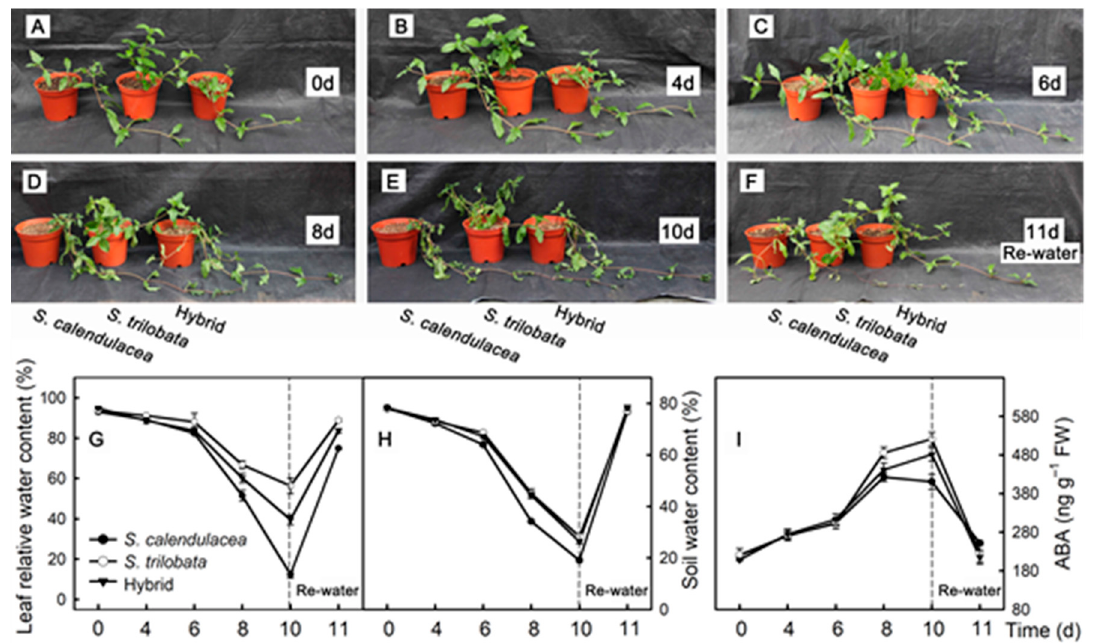
Figure 1. Phenotype and moisture content. Changes of phenotype ( A – F ), leaf relative water content ( G ), soil water content ( H ) and ABA content ( I ) of S . calendulacea , S . trilobata and their hybrid under drought stress and re-watered.